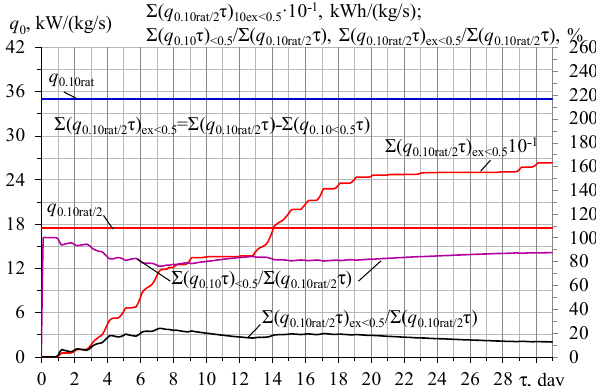
Figure 4. Monthly summarized values of design refrigeration energy exceedance ∑ ( q 0.10rat/2 τ ) ex<0.5 above consumed values ∑ ( q 0.10<0.5 τ ) within q 0.10 < q 0.10rat/2 , relative values of summarized exceedance ∑ ( q 0.10rat/2 τ ) ex<0.5 / ∑ ( q 0.10rat/2 τ ), and summarized refrigeration energy consumed ∑ ( q ∑ ( q τ ) τ 0.10 <0.5 / 0.10rat/2